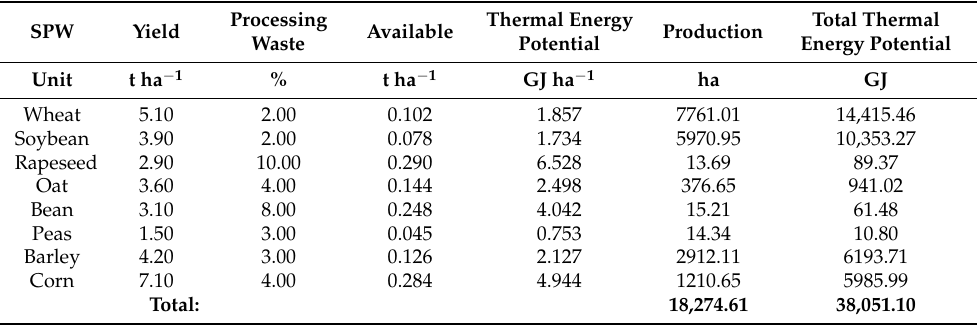
Table 3. Theoretical thermal energy potential of SPWs from Croatian seed production program; biomass and cogeneration power plants